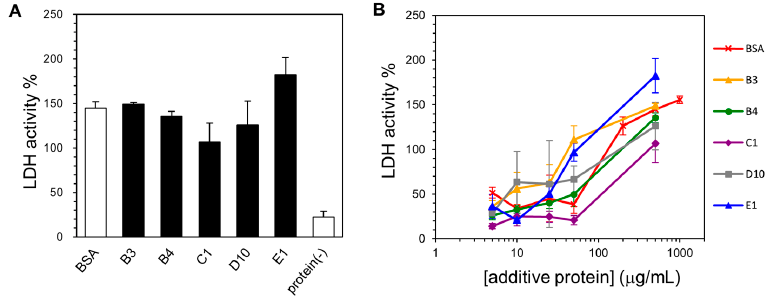
Figure 5. Lyophilization protection of LDH by human genome-derived IDPs and BSA. ( A ) LDH activities (final concentration of 50 μ g/mL) after lyophilization in the presence of 500 μ g/mL of the given additive protein. The LDH activity of the untreated sample was set to 100%. IDPs are colored as black. Protein (-) indicates LDH activity without lyophilization protectant; ( B ) LDH activities after lyophilization-resolubilizing with the given additive proteins at various concentrations. Error bars indicate the standard deviation of triplicate measurements.